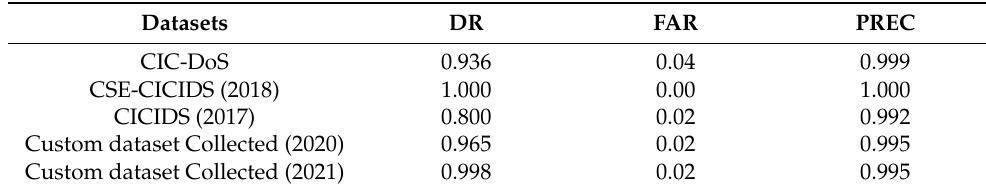
Table 5. System performance evaluation with datasets.